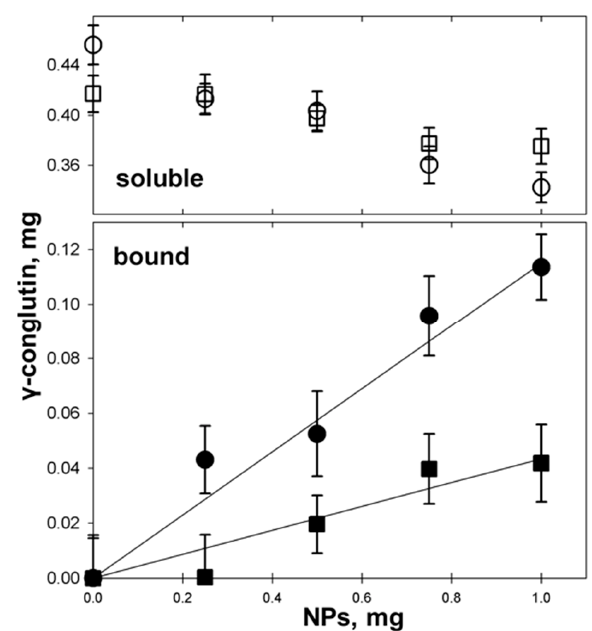
Figure 5. Absorption of γ C to polystyrene NPs at pH 7.3 (dots) and pH 4.5 (squares). Upper panel: soluble γ C after incubation with NPs (open symbols); lower panel: NP-bound γ C (closed symbols).